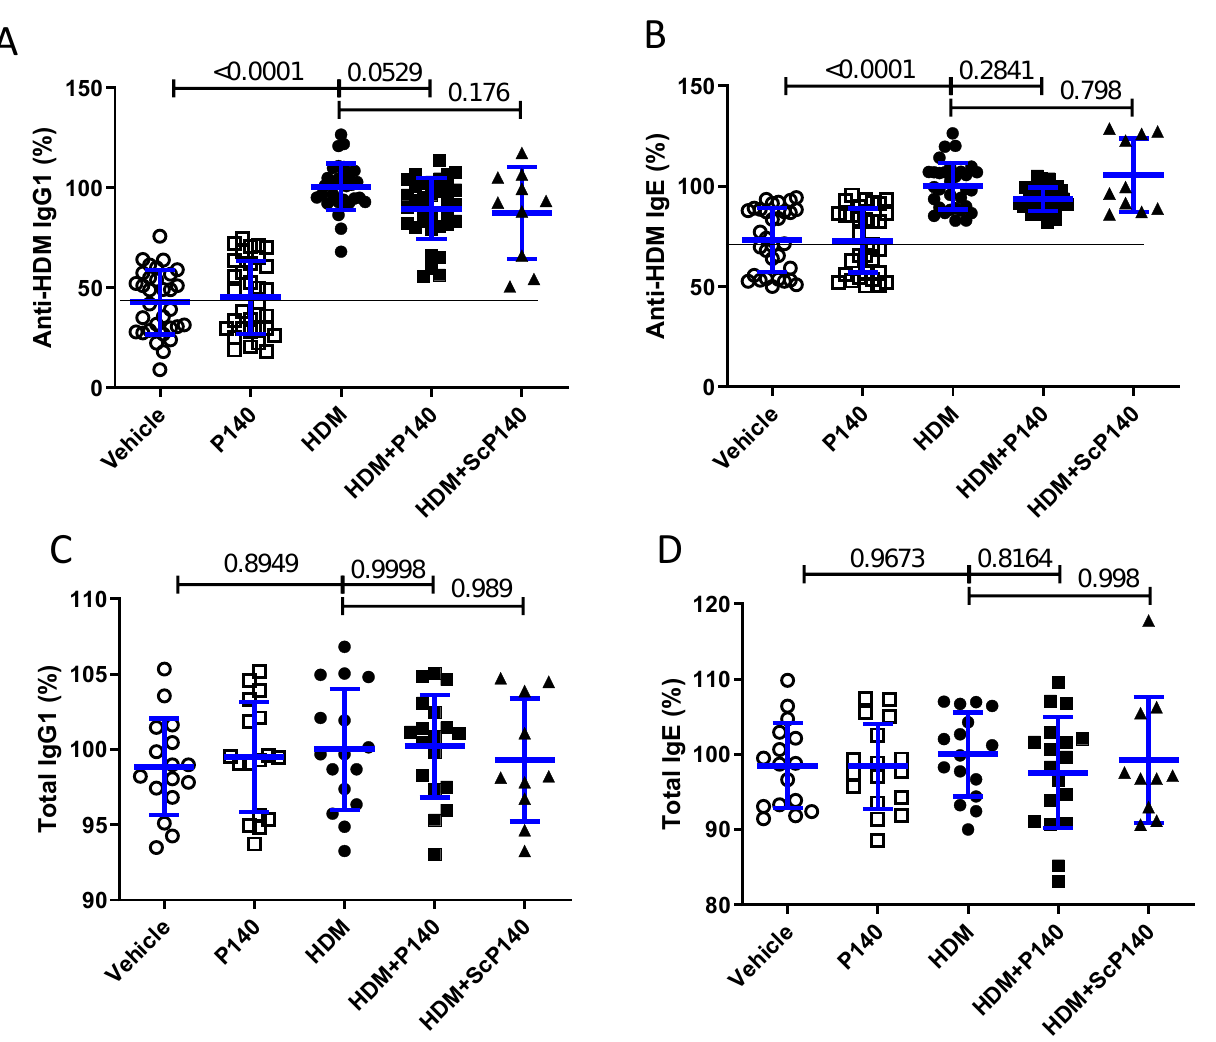
Figure 4. Effect of the P140 peptide on the levels of circulating anti-HDM IgG and IgE antibodies. The serum levels of specific IgG1 and IgE antibodies to HDM ( A , B ) and of IgG1 and IgE ( C , D ) were measured by ELISA. The level of Ig is expressed in percentage of respective HDM groups. The horizontal line indicates the background of the respective assays. The data are presented as the mean ± SEM ( n = 32 mice per group from four independent experiments).